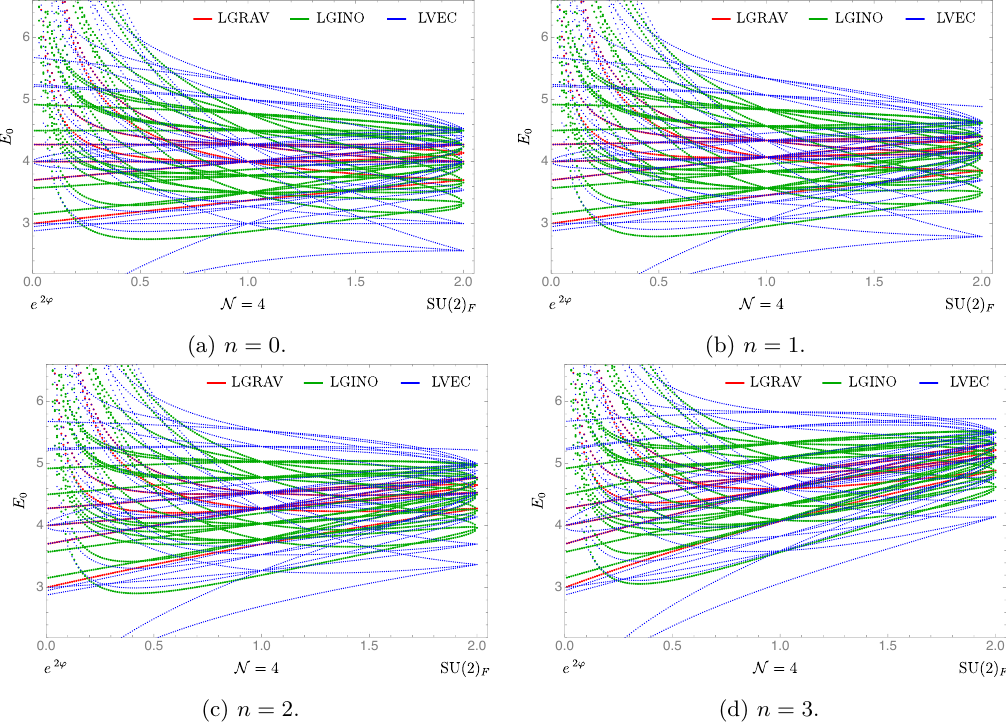
Figure 5 . N = 2 multiplets at KK levels ‘ = 2 and n = 0 , . . . , 3 on Family II at χ = 0 , with T = 2 π